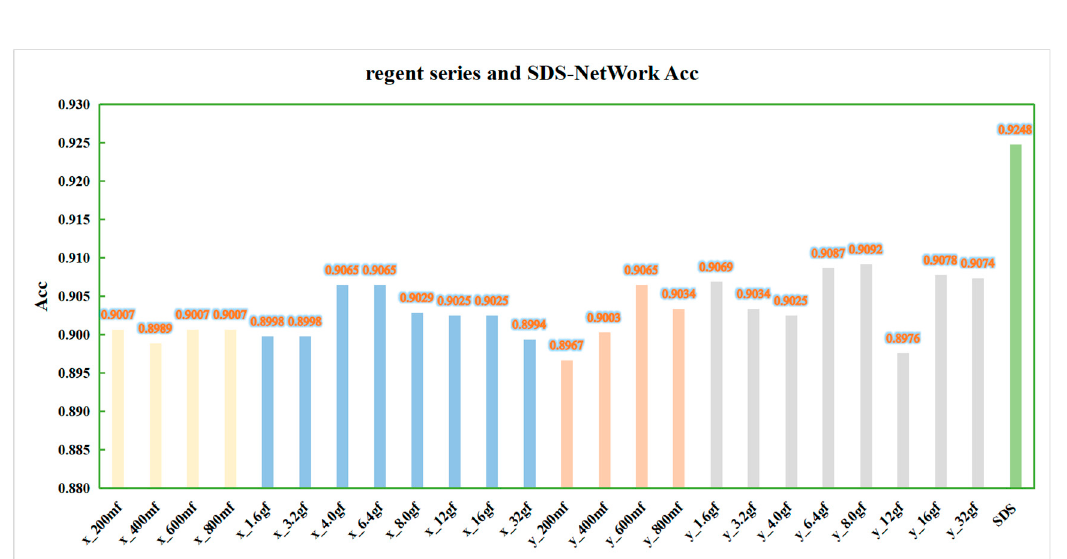
Figure 8. SDS-Network and regnet algorithm Acc comparison diagram. x_200mf–x_800mf are marked in yellow; x_1.6gf–x_32gf are marked in blue; y_200mf–y_800mf are marked in orange; y_1.6gf–y_32gf are marked in gray; and SDS is marked in green.